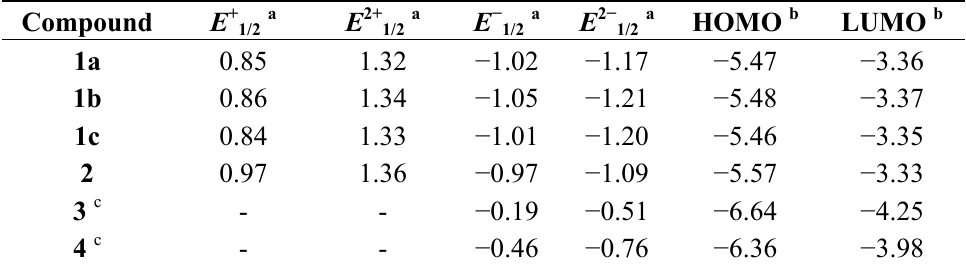
Table 3. Summary of half-wave redox potentials, HOMO and LUMO energy levels for perylene bisimide